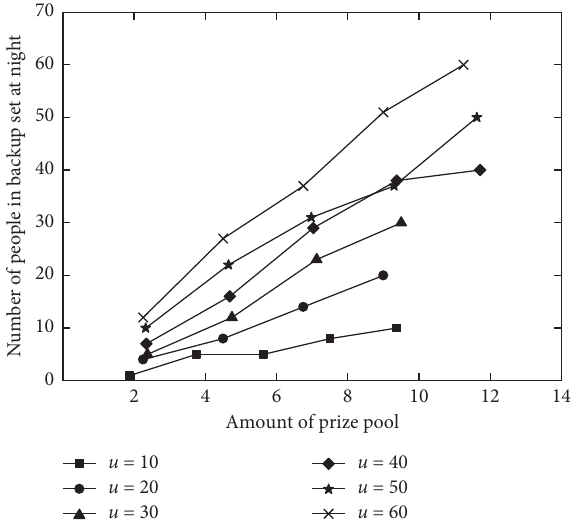
Figure 3: Number of people in backup set at night.